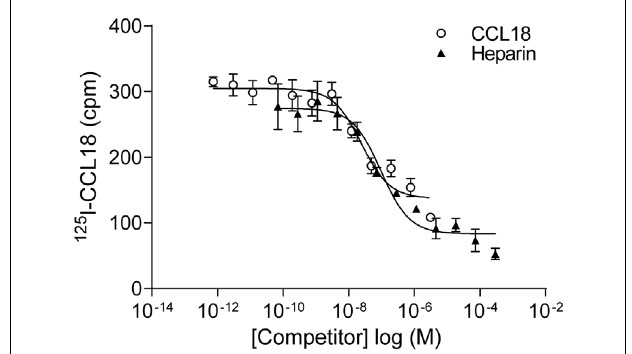
FIGURE 8 | Equilibrium competition binding assays of 125 I-CCL18 on PBL .The binding of 125 I-CCL18 to PBL was competed with Heparin (heparin-3393) (IC 50 : 97.43nM) and CCL18 (IC 50 : 24.37nM). Data are expressed in cpm ± SEM. Data points are in triplicate. One representative experiment out of six is shown.